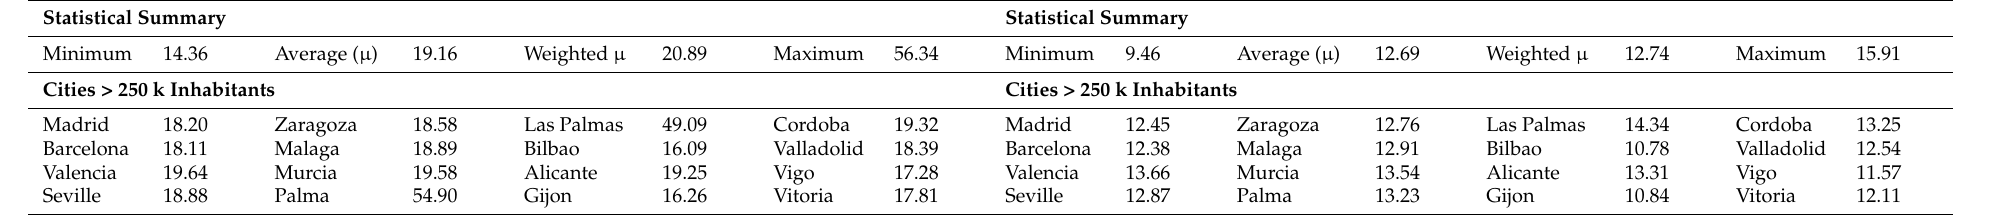
Figure A9. ST NPE in tons CO 2 eq (S3 (auxiliary electricity supply scenario) left , and S4 (auxiliary natural gas supply scenario) right ).